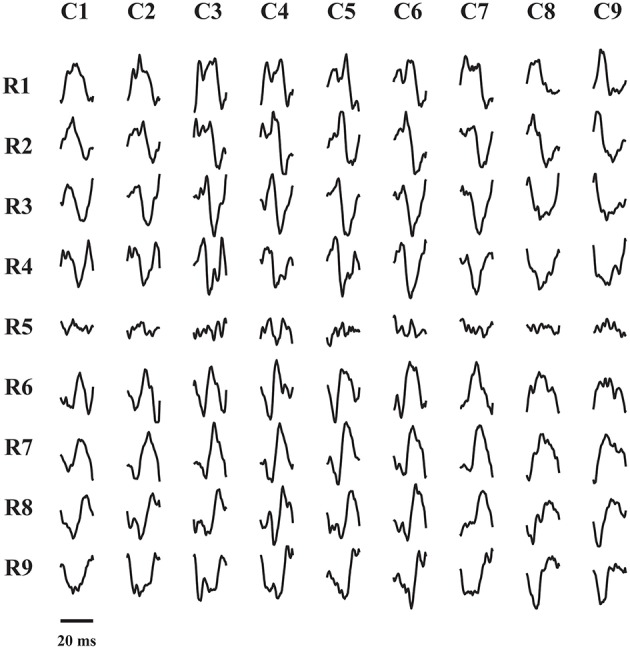
Single-differential sEMG MUAP waveforms of MUs from different sEMG channels. The corresponding MU was identified with accuracy >90%.